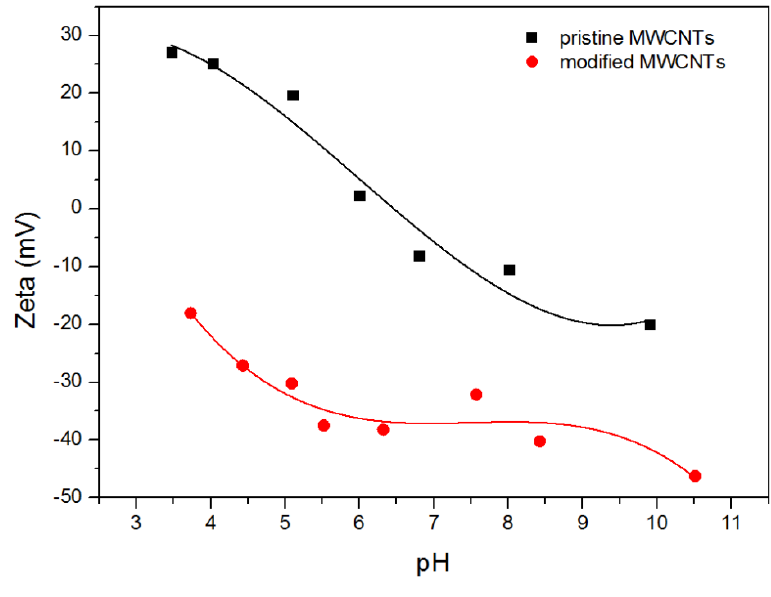
Figure 1. Zeta potential of pristine ( ■ ) and modified ( ● ) MWCNTs vs. pH.